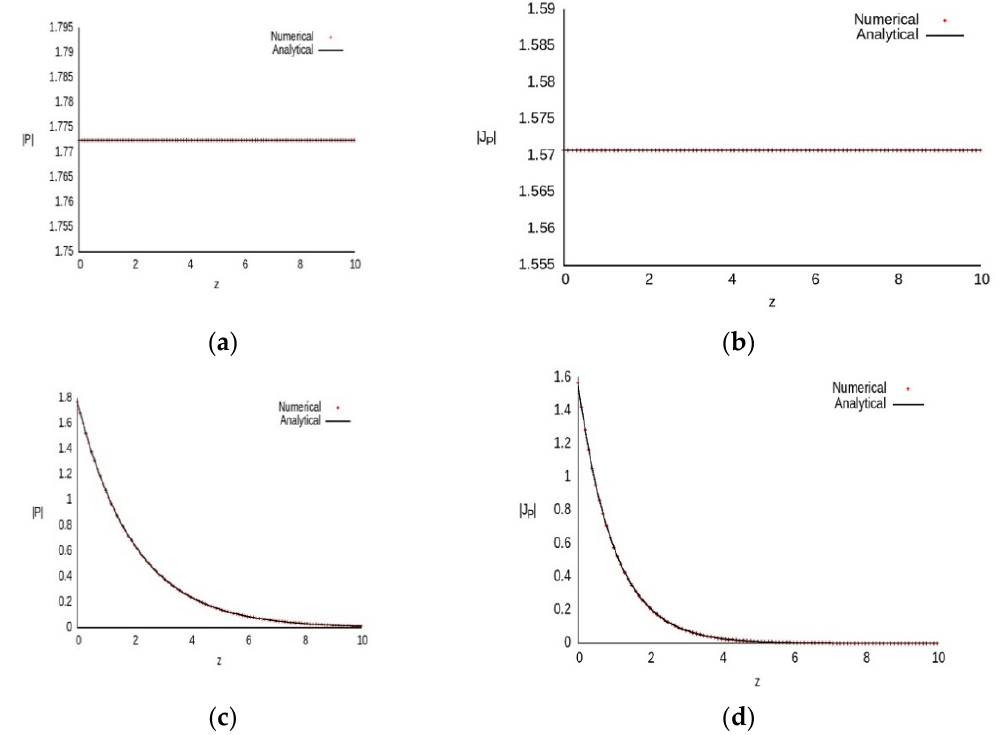
Figure 7. Evolution of the modulus of the invariants J p ( z ) (4a) and modulus of the function P ( z , L t ) (4c) computed via computer simulation (red dotted line) and analytically (black solid line) for the following parameters sets: ( D 2 ω , ν , ν ω , δ 0 , n 0 ) = (0, 0.3, 0, 0, 0), (0, 0, 0.05, 0, 0), (0, 0.3, 0.05, 0, 0), ( − 0.01, 0.3, 0, 0, 0), ( − 0.01, 0, 0.05, 0, 0), ( − 0.01, 0.3, 0.05, 0, 0), ( − 0.01, 0, 0.05, 0, 1) ( a , b ); ( − 0.01, 0.3, 0, 1, 0), ( − 0.01, 0.3, 0.05, 1, 1) ( c , d ).